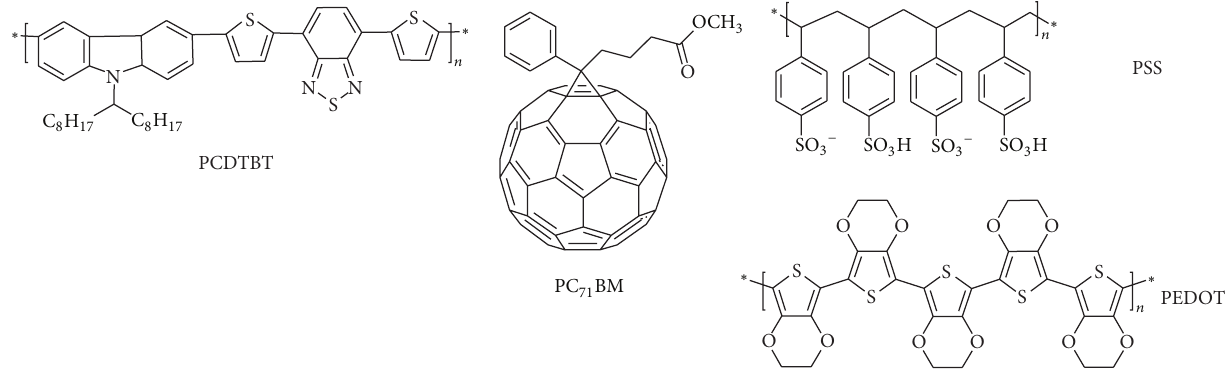
Figure 1: Molecular structure of PCDTBT, PC 71 BM, and PEDOT: PSS.